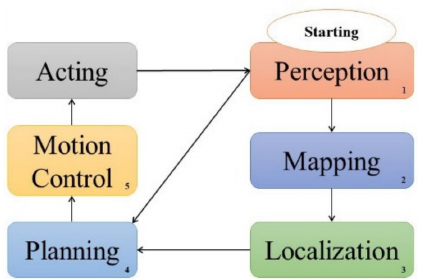
Figure 1. Flow diagram of the stages of the AWMR navigation